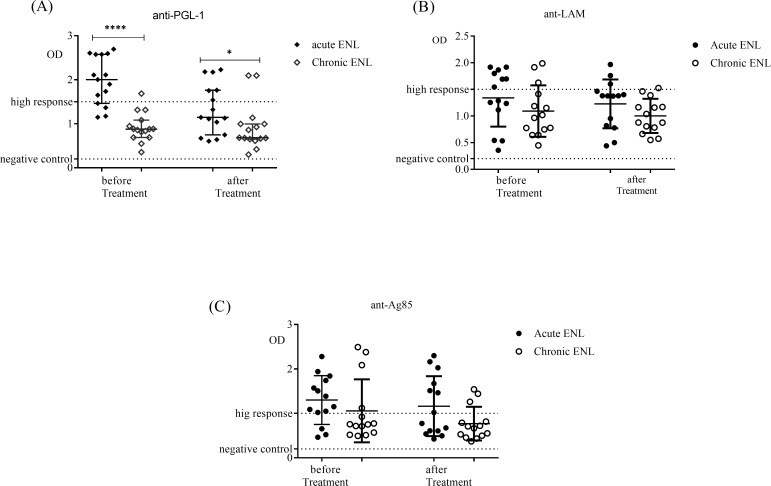
Serological responses to antigens in patients with acute ENL (n = 15) compared with patients with chronic ENL (n = 15) before and after treatment.(A): response to M. leprae PGL-1 antigen; (B): response to M. leprae Ag85 antigen; (C): response to M. leprae LAM antigen; Statistical test: Mann-Whitney unpaired test (U). * P≤0.05; ** P<0.005. Error bars show median ± interquartile range.